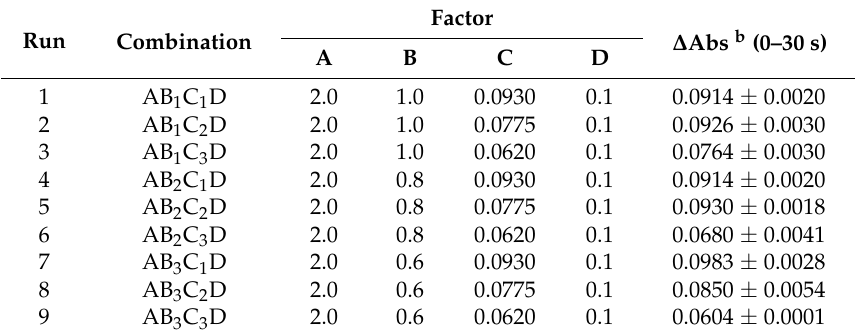
Table 4. A full factorial design for the analysis of the effects of AMP, bromothymol blue on the Adk activity assay with the constants of A and